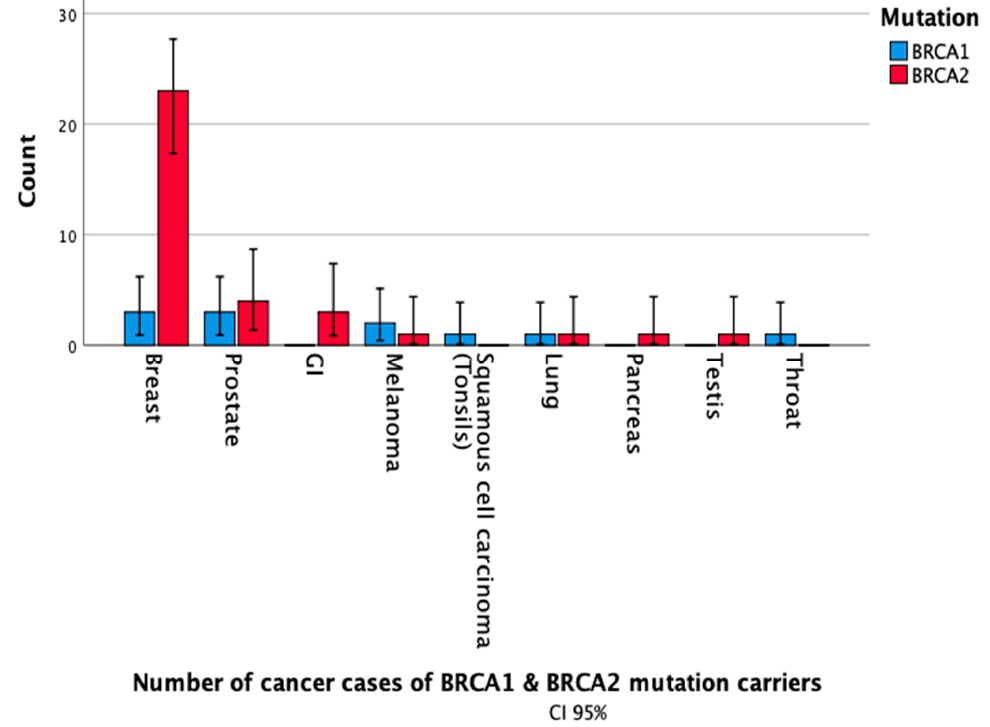
mutation (Supplementary Table S1). There were no statistically significant differences observed in the primary breast tumor characteristics between mutation groups.